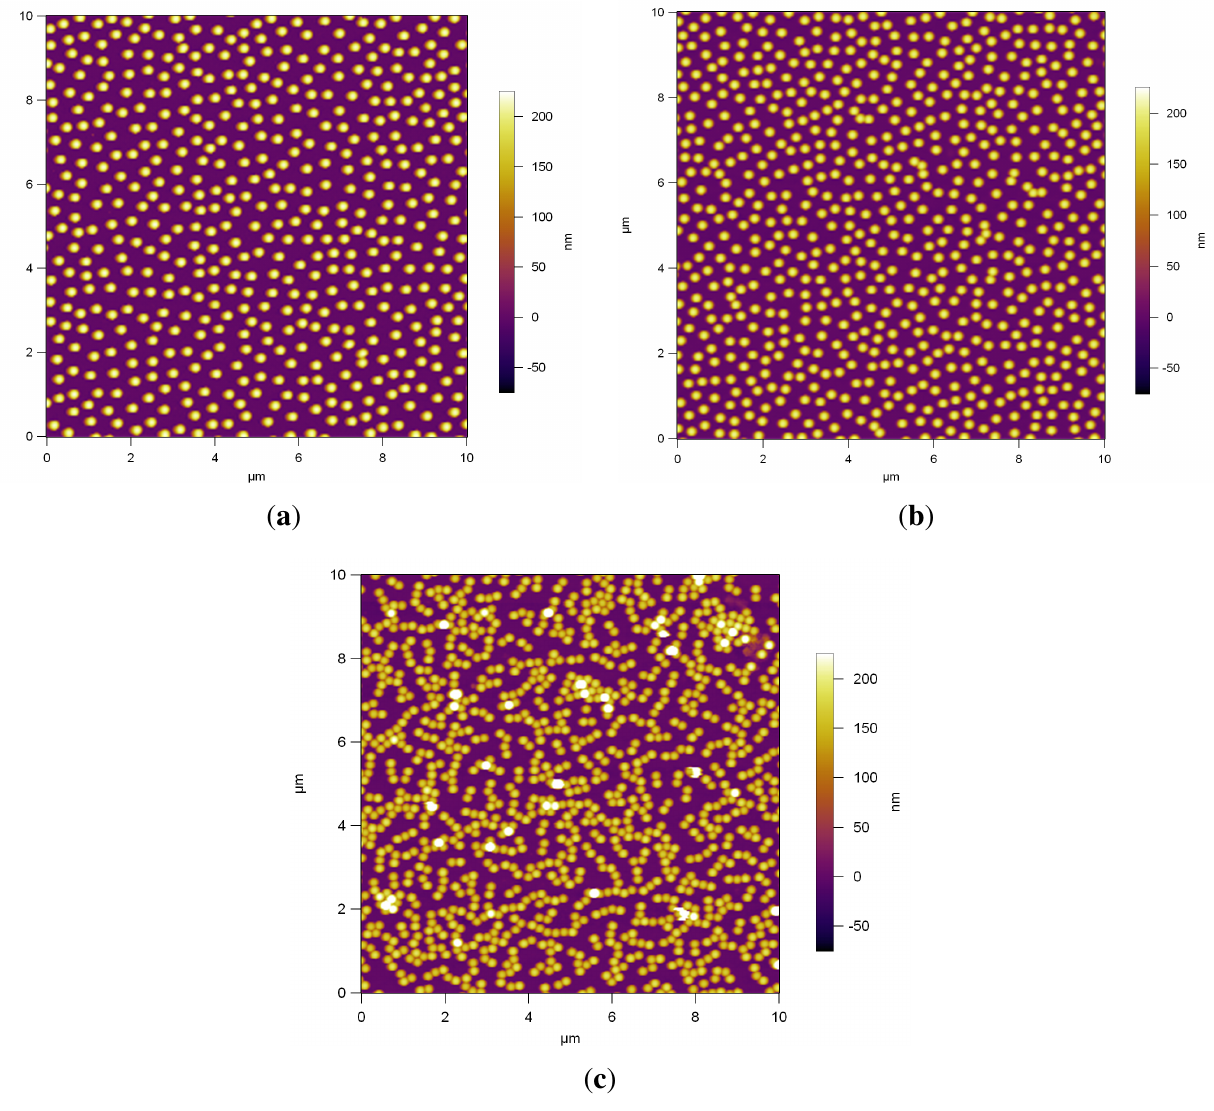
Figure 4. AFM height profiles of assembled PS NPs via dip coating on, Si/PEI/(PSS/PAH) 2 ( a ); PDMAEMA brushes ( b ); quaternized PDMAEMA brushes ( c ). ( a ) The area fraction is 13.4%; ( b ) The area fraction is 16.3%; ( c ) The area fraction is